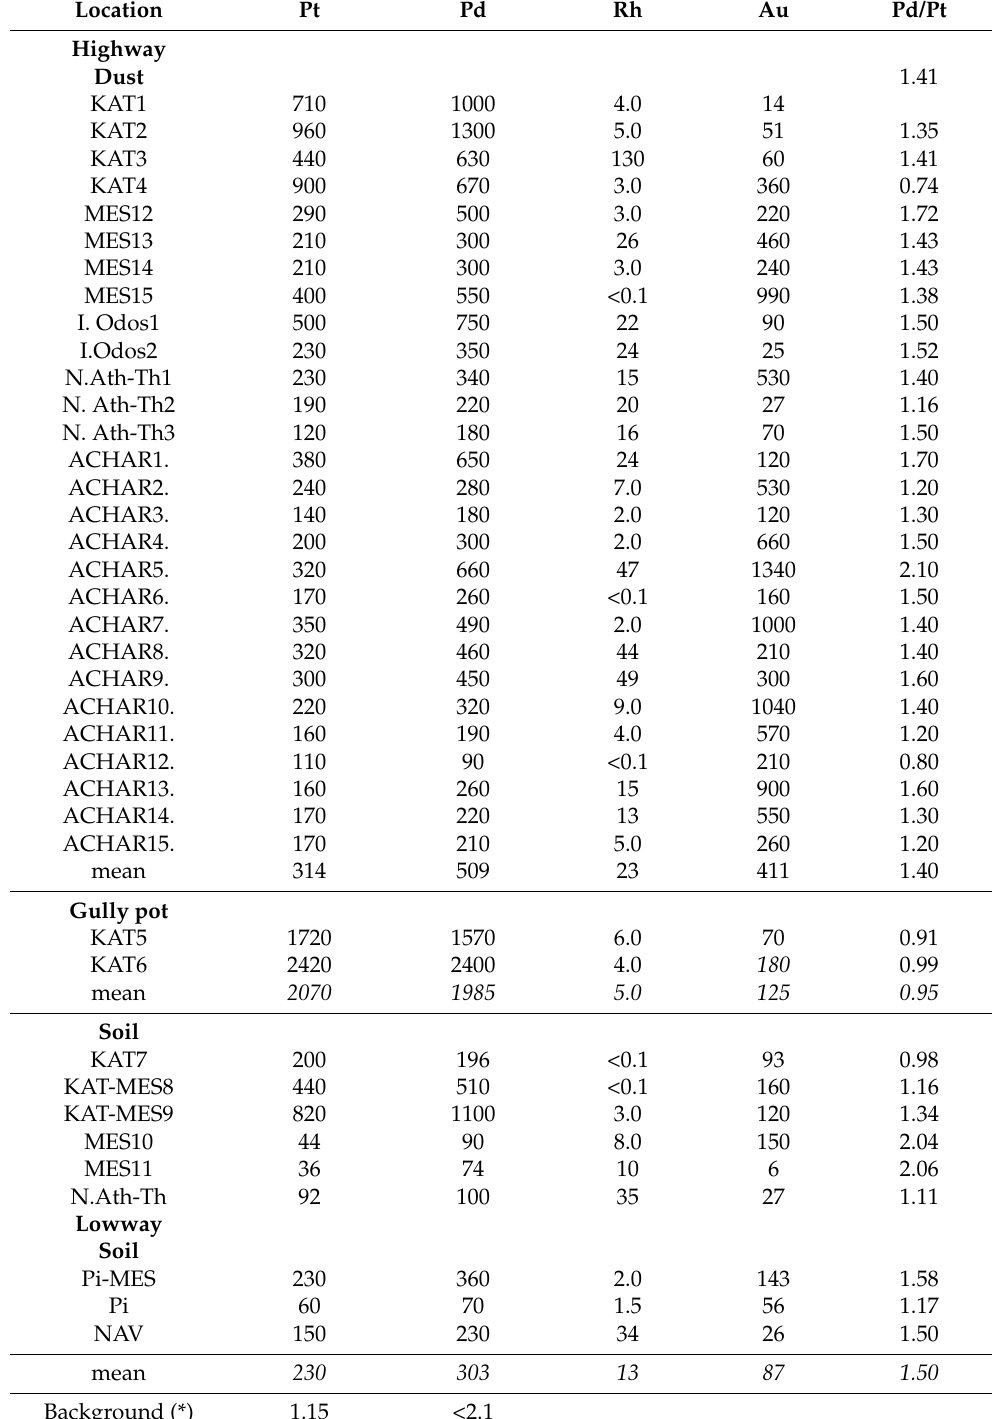
Table 1. Precious metal contents ( µ g/kg) in dust and soil samples along roadsides (Figure 1). Background values (*)